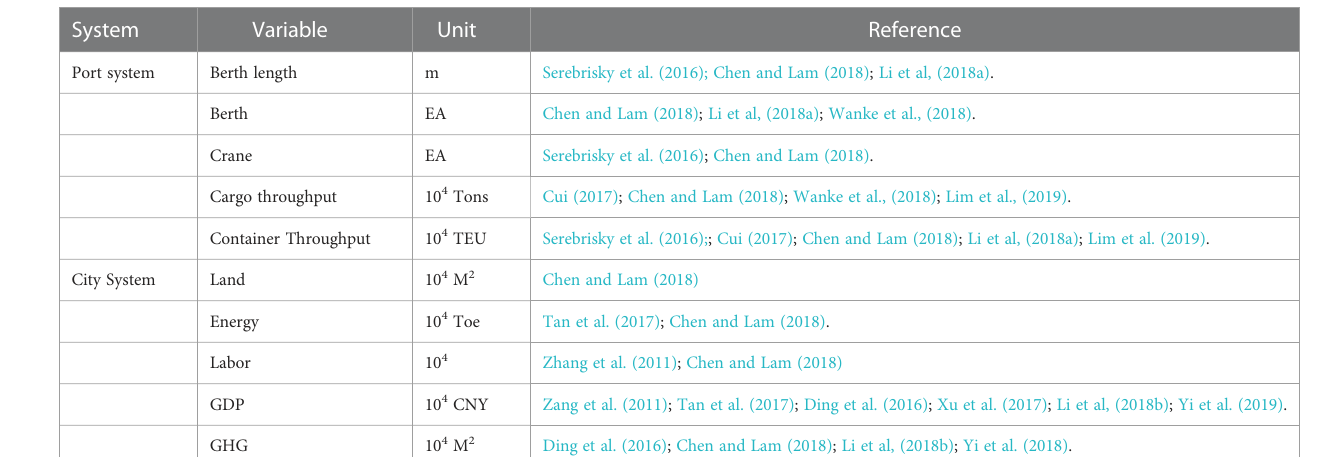
TABLE 2 Criteria for sustainability evaluation of